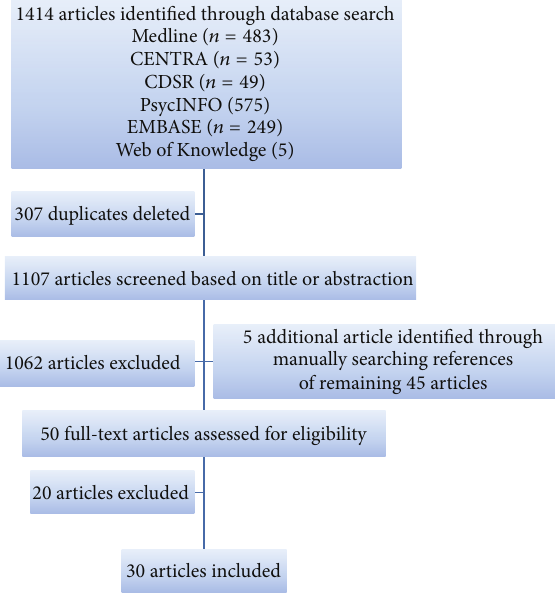
Figure 1: Flow diagram of study